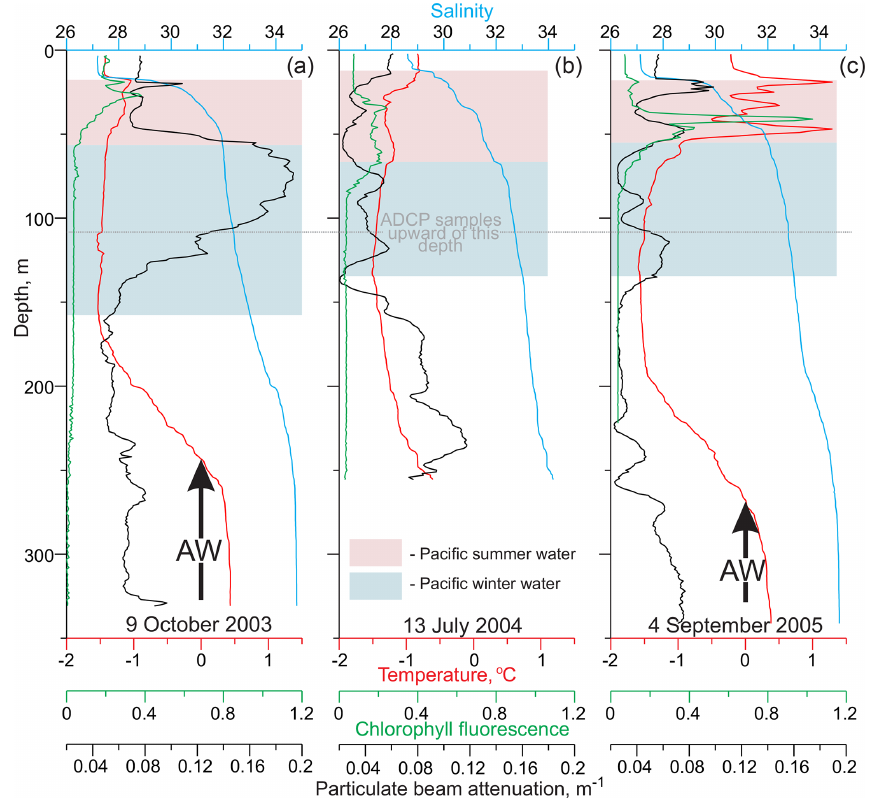
Figure 2. Vertical temperature (red), salinity (blue), chlorophyll fluorescence (green), and particulate beam attenuation (black) profiles taken at (a) mooring deployment on 9 October 2003, (b) on 13 July 2004, and (c) at mooring recovery on 4 September 2005. Pink and blue shading and black arrows highlight Pacific Summer Water (PSW), Pacific Winter Water (PWW), and Atlantic Water (AW), respectively, following Dmitrenko et al.